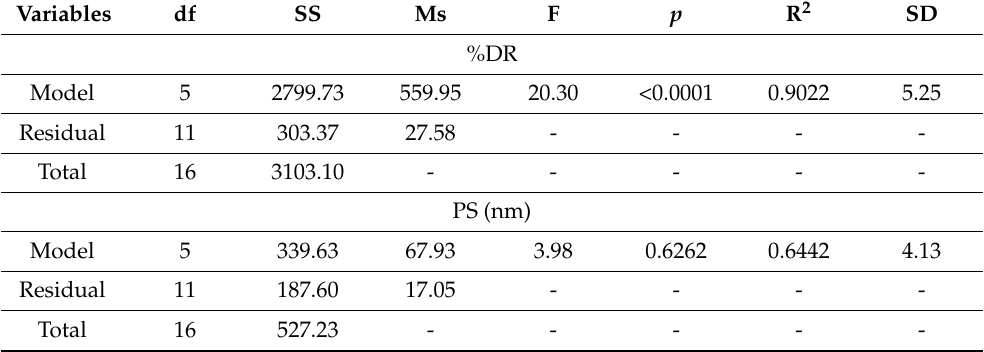
Table 1. Details of response regression and analysis of variance for various parameters. Table 1. Cont.